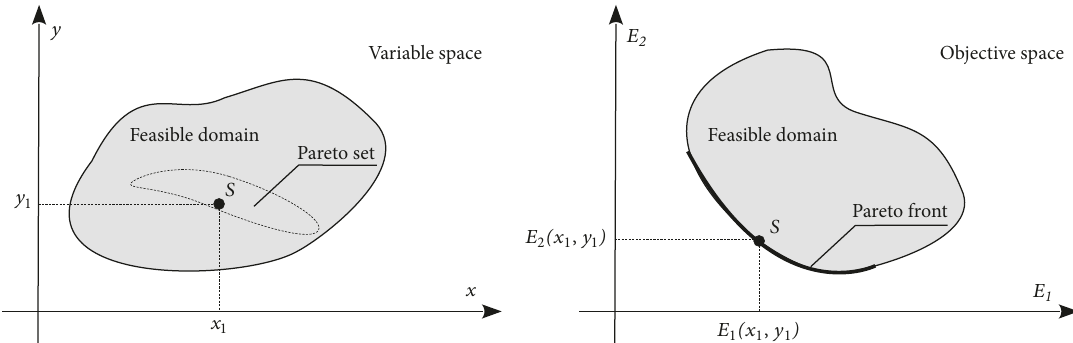
Figure 3: Hypothetical correspondence between variable space and objective space for a bi-objective minimisation